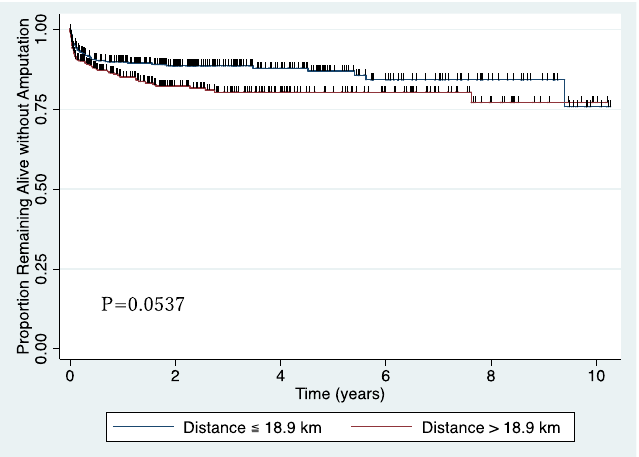
Figure 2. Amputation-free survival curve. Table 2. Cox proportional hazards model for lower extremity amputation.